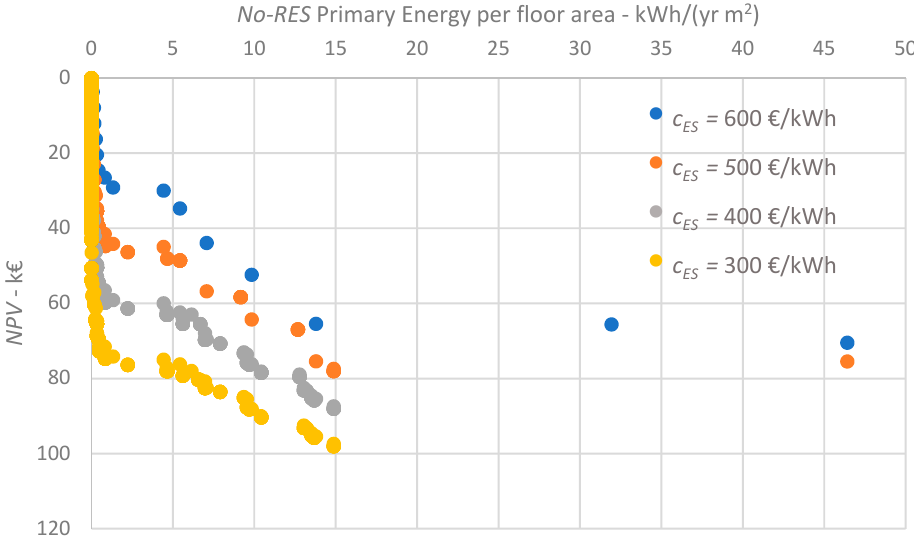
Figure 18. Sensitivity analysis of the Pareto frontier depending on the ES unitary cost. Table 6. Percentiles of the number of PV collectors and nominal ES capacity as a function of the unitary cost of the electrochemical storage.